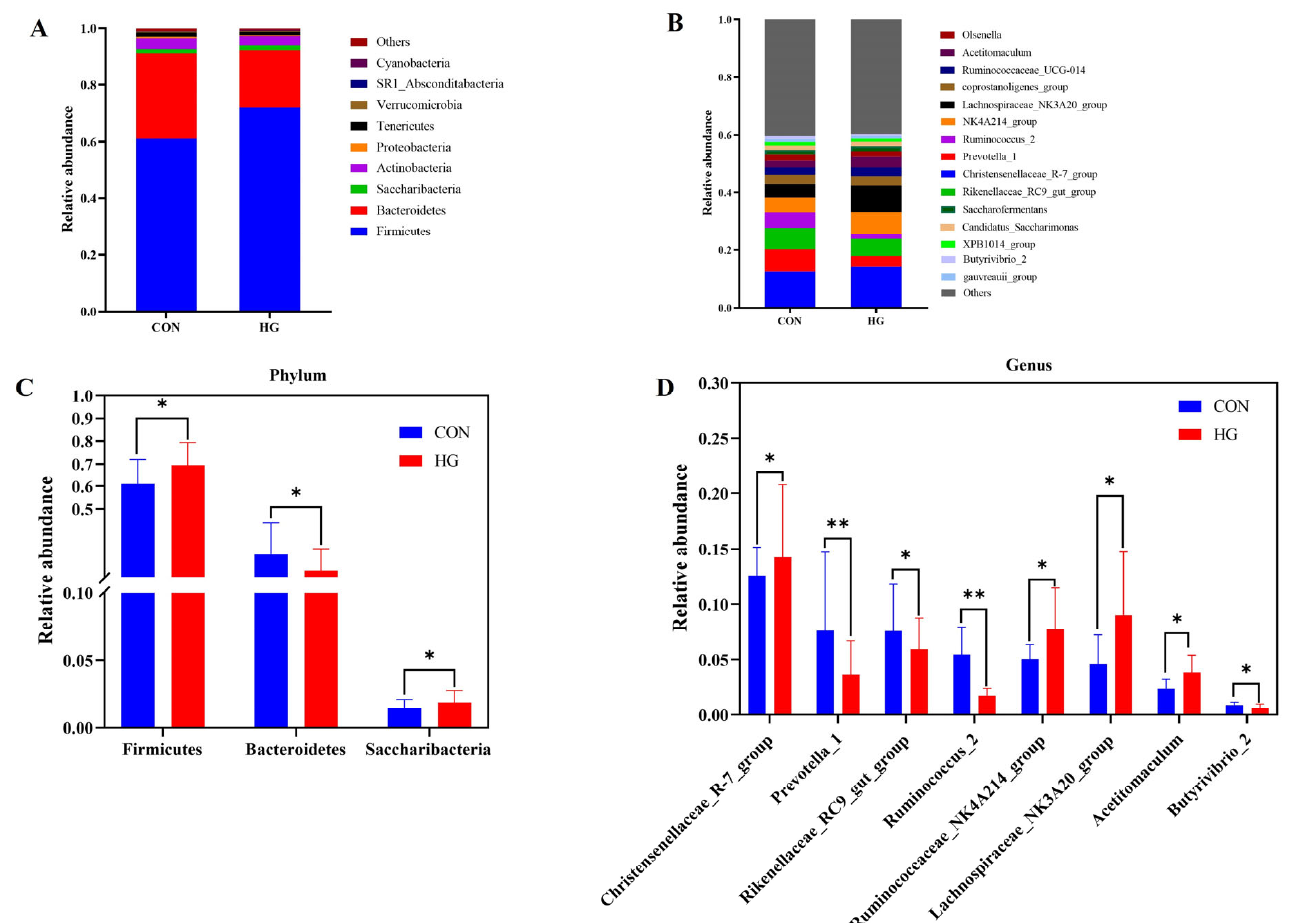
Figure 2. Bacterial community composition and significant differences of yaks fed different diets. CON, hay group; HG, high-grain group. ( A ) Phylum level; ( B ) genus level; ( C ) the bacteria with significant differences at the phylum level; and ( D ) the bacteria with significant differences at the genus level. * p < 0.05; ** p < 0.01.